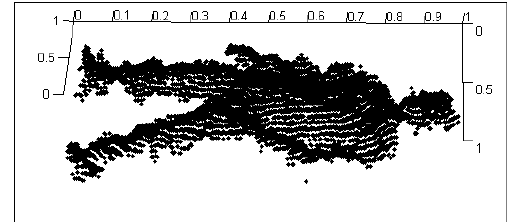
Figure 2. The normalized point cloud data of human body.